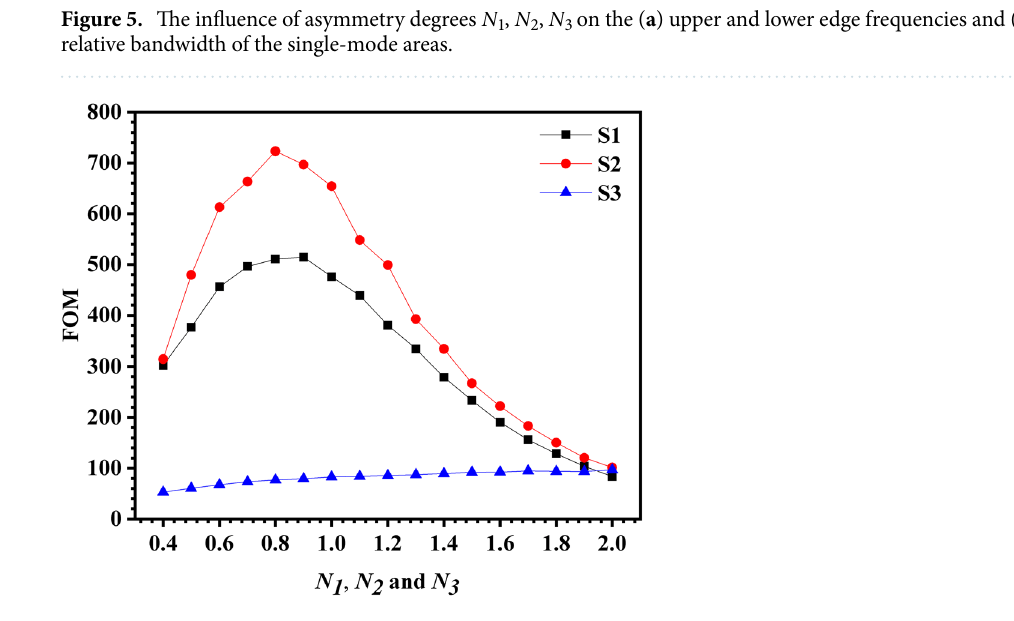
Figure 6. The influence of asymmetry degrees on FOM of the three